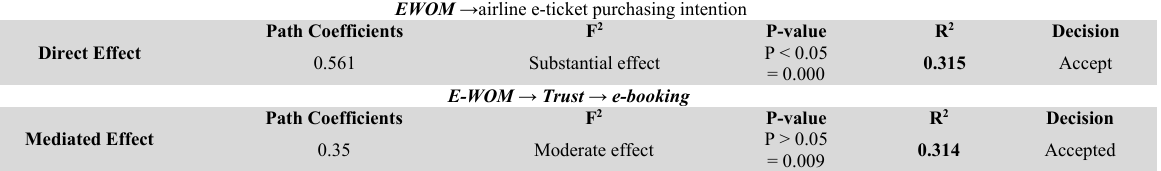
The Results of the second